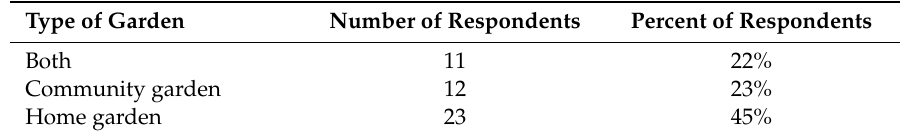
Table A3. Type of garden used by participants.